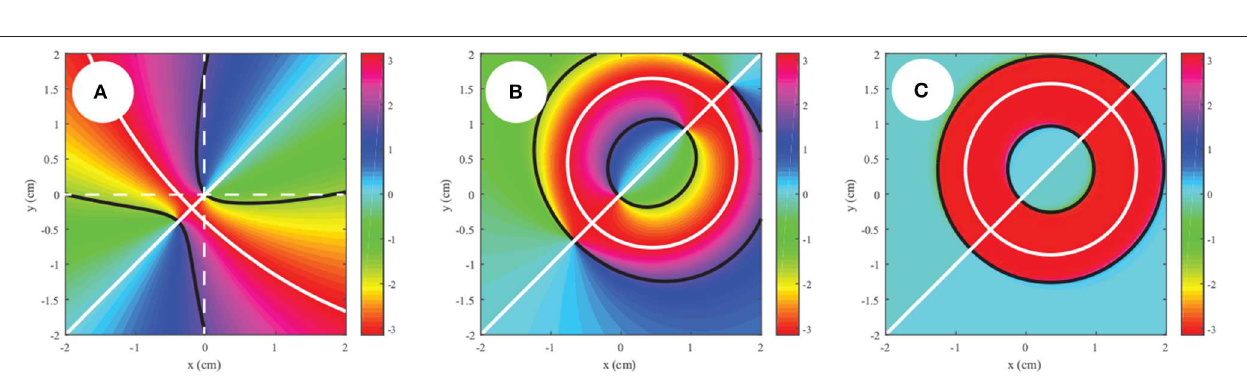
(0.35,0.35) cm. Dashed lines have been included to show the position of the coordinate system origin. =